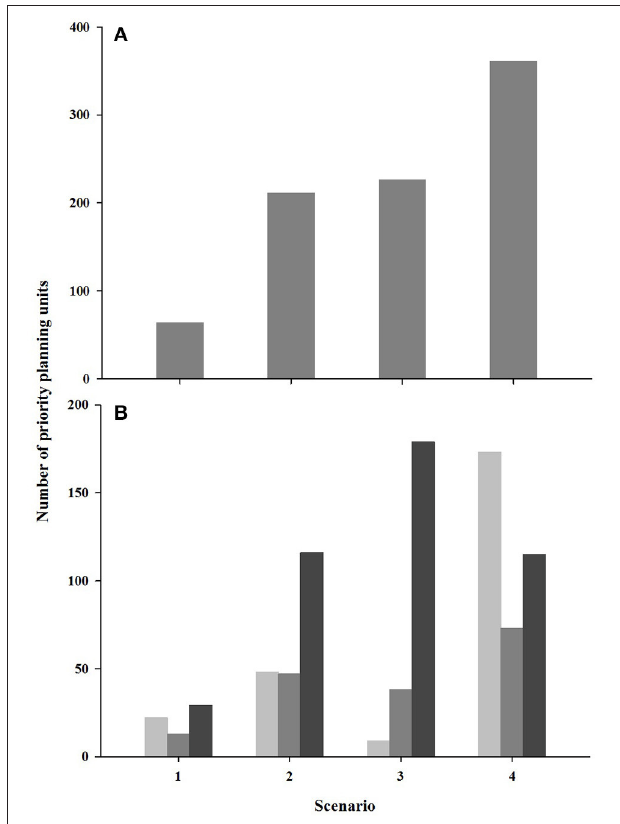
FIGURE 6 | Comparison of the number of priority planning units (PUs) (selection frequency higher than 50%) of 100 runs with Marxan. For each scenario (A) , for each scenario in each zone (B) . Light gray bar represents the north, intermediate gray the central and dark gray the south